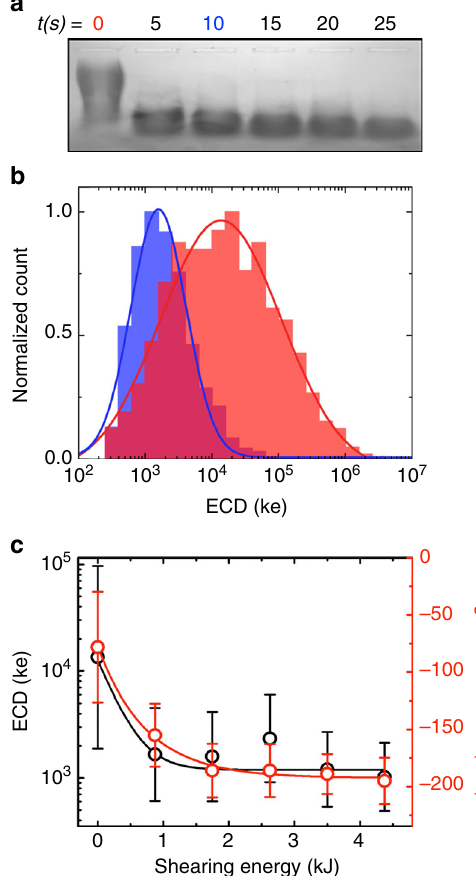
Fig. 2 Assessment of HA mechanical shearing. a Gel image of polydisperse HA under increasing durations of exposure to a 175 W ultrasonic shearing bath, demonstrating increasing fragmentation. b ECD histograms obtained from the 0 s (red) and 10 s (blue) samples from a . Solid lines are log- normal fi ts (Gaussian on a log scale) to the data. We observe a shift in the mean from 1.3 × 10 4 ke (red) to 1.6 × 10 3 ke (blue) after shearing with population width (standard deviation) reduced from 9.4 × 10 4 ke (red) to 3.5 × 10 3 ke (blue). c HA ECD (left, black) and gel migration distance (right, red) for all investigated shearing conditions, yielding nearly identical trends. Solid lines are exponential fi ts to the respective data. In b , c ECD data consist of t = 0 ( n = 1067, same data as Fig. 1c), 5 ( n = 6331), 10 ( n = 1247), 15 ( n = 617), 20 ( n = 1008), and 25 s ( n = 781) and error bars represent the standard deviations of log-normal fi ts to the measured via MALLS or MS), and provides only semi- quantitative data.